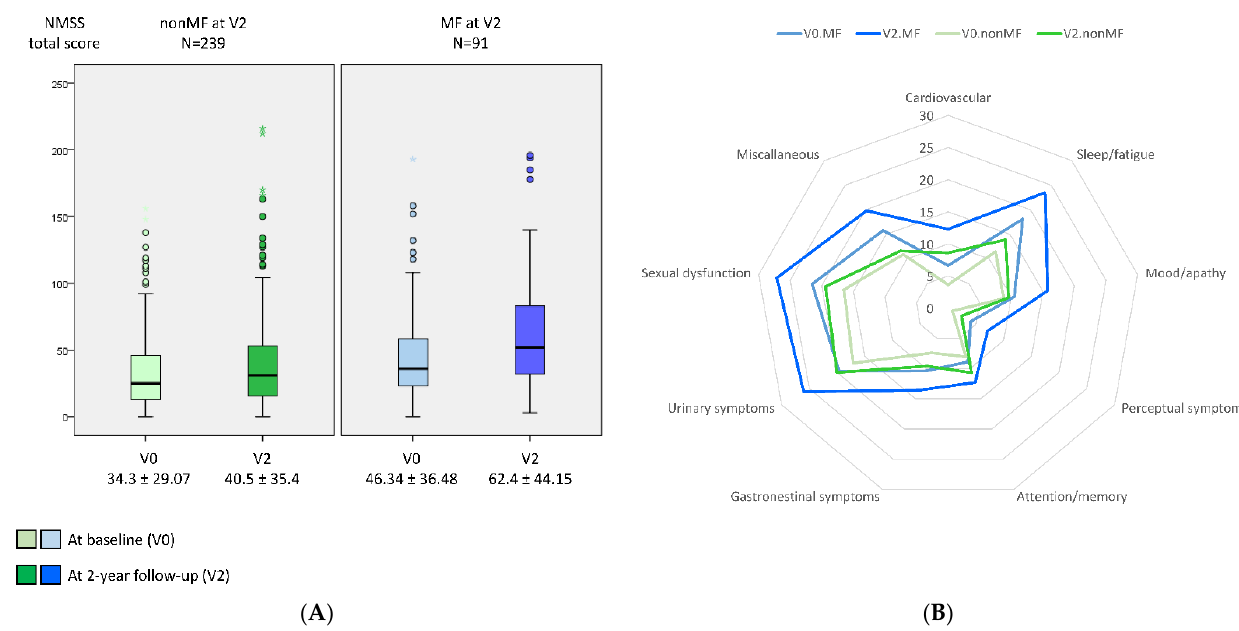
Figure 1. ( A ) NMSS total score ( y -axis) at baseline (V0) and after a 2-year follow-up (V2) in PD patients who developed MF at V2 (MF at V2 (PD-MF V2 ); N = 91) and those patients who did not develop MF at V2 (nonMF at V2 (PD-nonMF V2 ); N = 239). NMSS total score at V0, PD-MF V2 vs. PD-nonMF V2 , p = 0.001; NMSS total score at V2, PD-MF V2 vs. PD-nonMF V2 , p < 0.0001; change in the NMSS total score from V0 to V2 in PD-MF V2 , p < 0.0001; change in the NMSS total score from V0 to V2 in PD-nonMF V2 , p < 0.0001; comparison between the change in the NMSS total score from V0 to V2 in PD-MF V2 vs. PD-nonMF V2 , p = 0.021. Data are presented as box plots, with the box representing the median and the two middle quartiles (25–75%). ( B ) Mean score on each domain of the NMSS at V0 and at V2 in both groups, PD-MF V2 and PD-nonMF V2 . At V0, the difference was significant